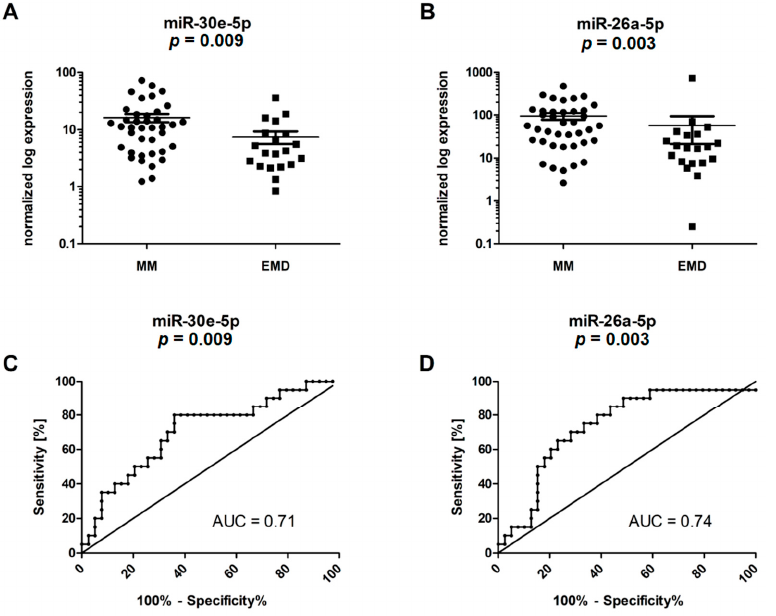
Figure 2. RT-qPCR validation and ROC analysis of selected microRNAs. ( A ) MiR-30e-5p was significantly downregulated in EMD vs. MM patients ( p = 0.009). ( B ) MiR-26a-5p was significantly downregulated in EMD vs. MM patients ( p = 0.003). ( C ) MiR-30e-5p enabled discrimination between MM and EMD patients (sensitivity 80.0%, specificity 64.1%; AUC = 0.71, cut-off = 8.8054). ( D ) MiR- 26a-5p enabled discrimination between MM and EMD patients (sensitivity 80.0%, specificity 61.5%; AUC = 0.74, cut-off = 37.6610).